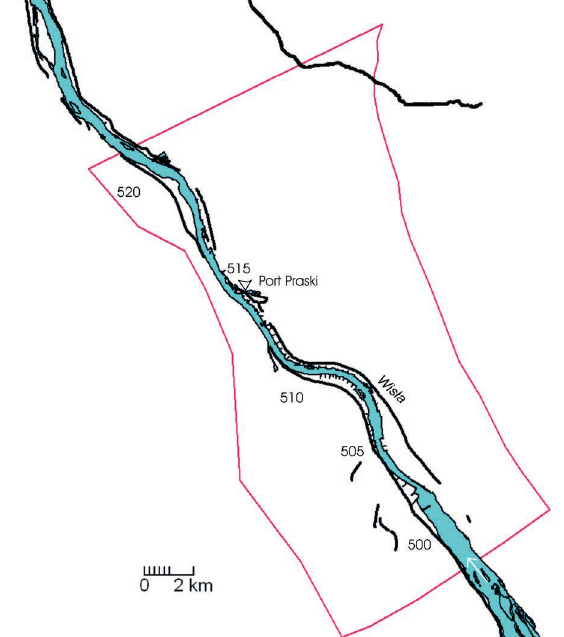
Fig. 2 Outline of the modelled area and location of the flood protective dikes along the Vistula River valley in the Warsaw